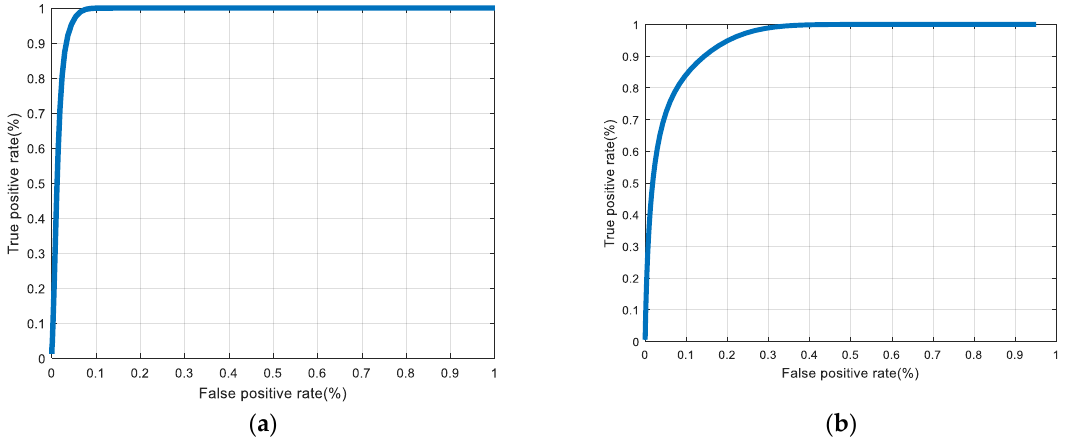
Figure 24. ROC curves for the system using an encrypted kernel in the IWT with different keys of encryption in the presence of noise with a variance of ( a ) = 0.01, and ( b ) = 0.02.